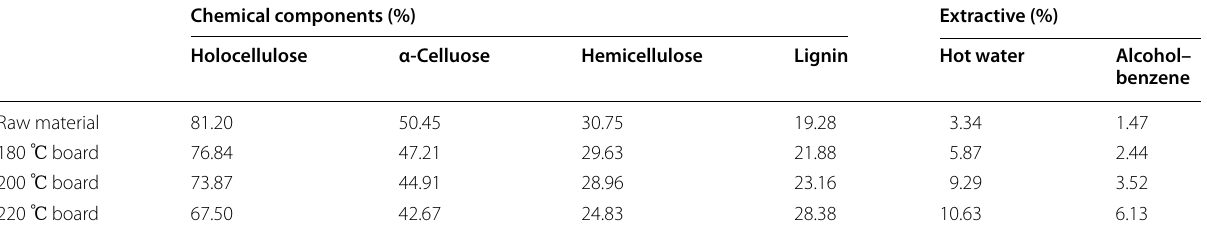
Table 4 Chemical composition of raw materials and binderless boards at different temperatures of Broussonetia